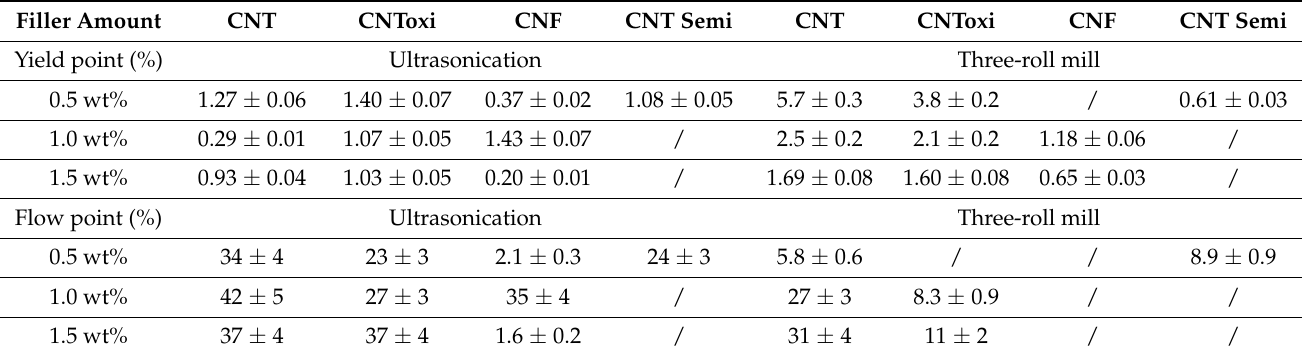
Table 4. Determination of the yield point and the flow point, representing the end of the LVE and the turnover of the viscoelastic behavior,